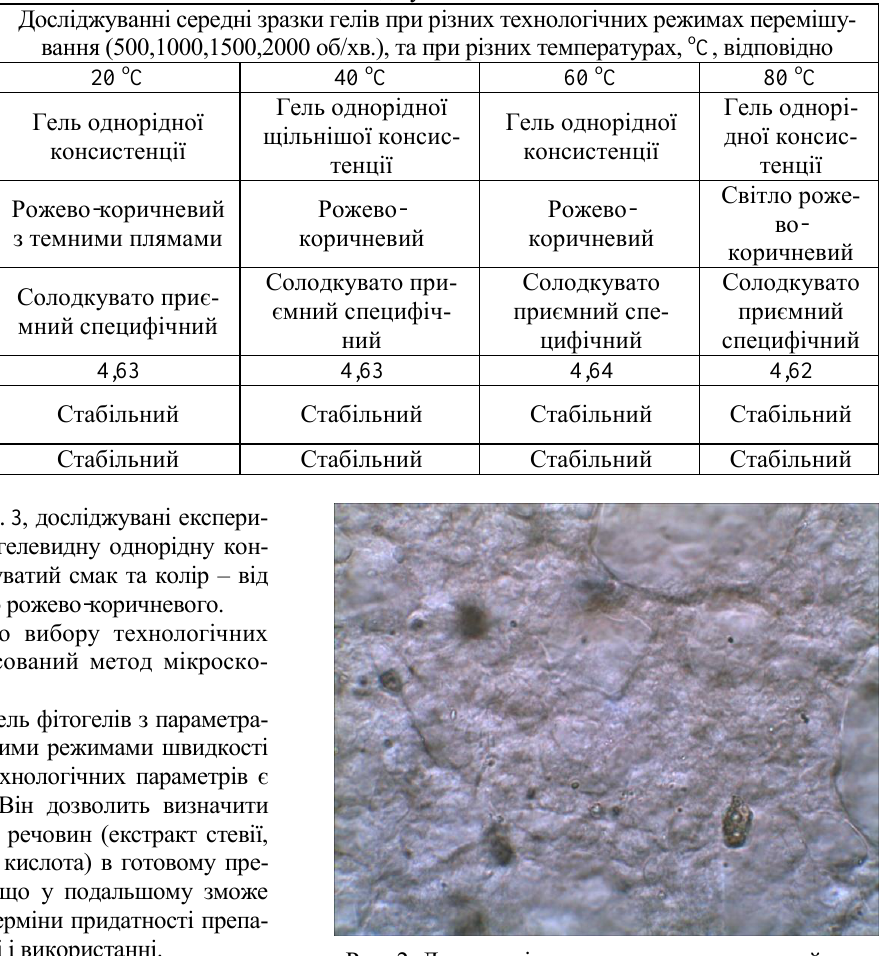
Рис. 2. Дисперсність гелю, що приготований при температурі 20 o C і 1000 об хв., збільшення × 400